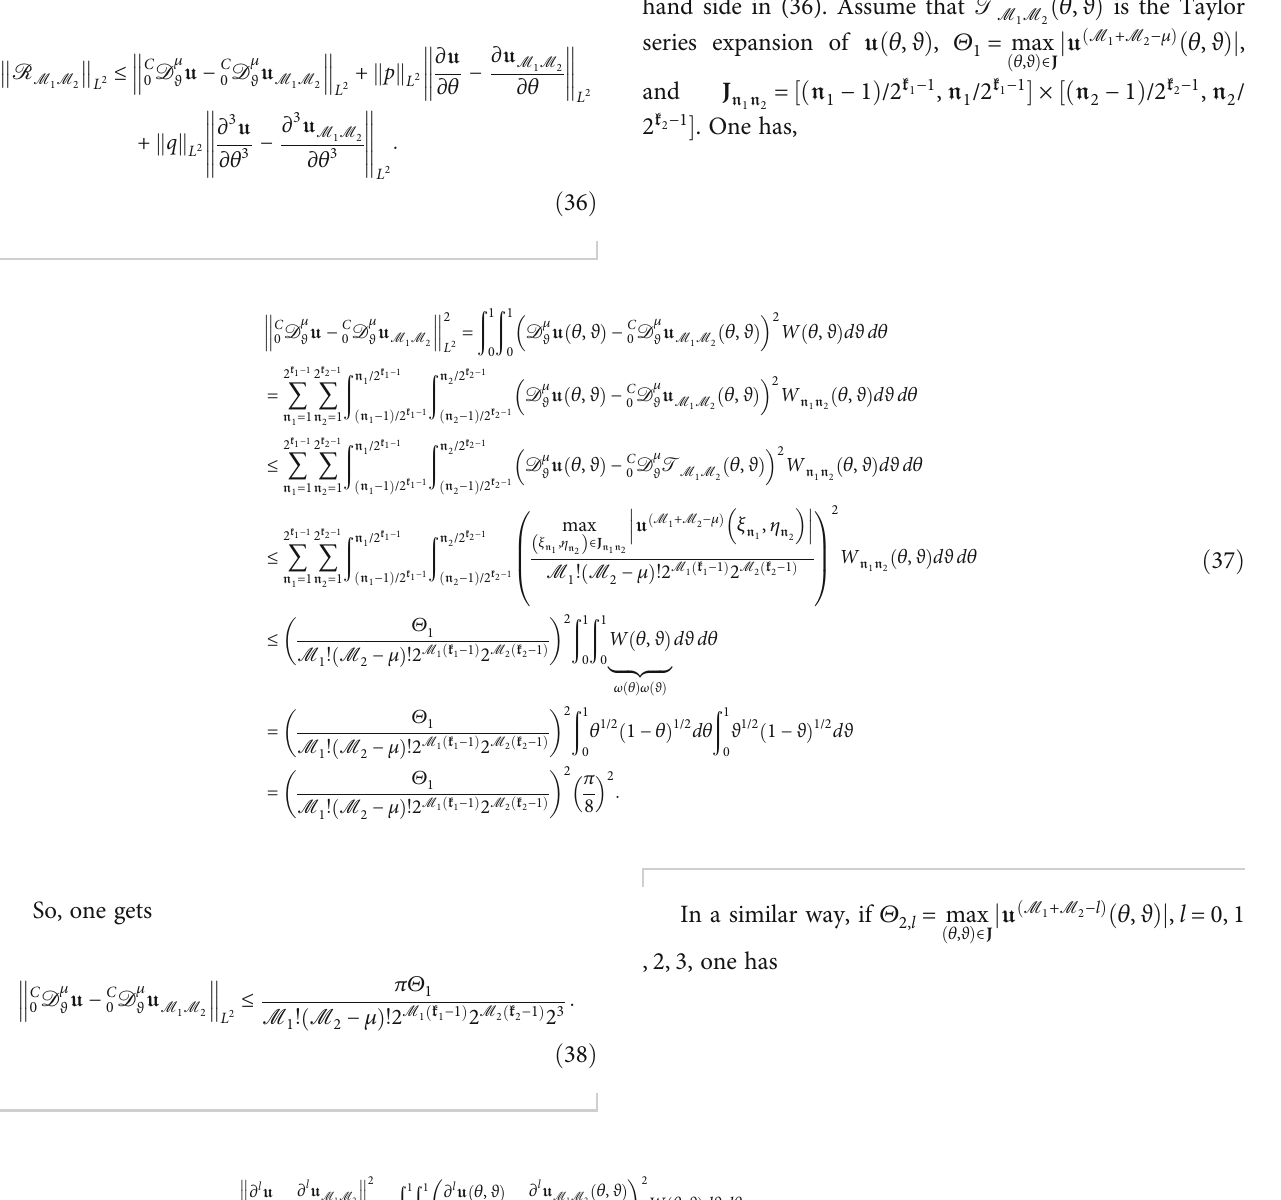
First, error bounds are calculated for terms on the right- hand side in (36). Assume that T M